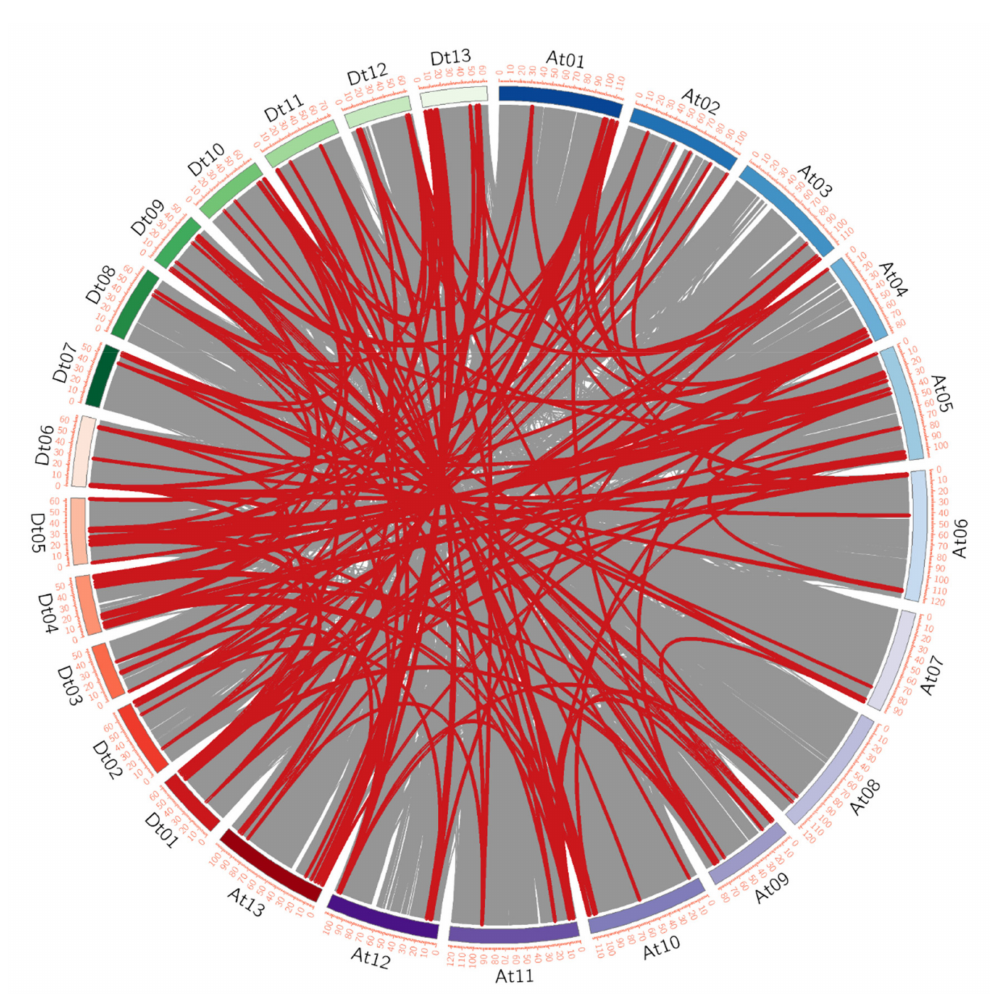
Figure 3. The syntenic relationship of GhAAT . The synteny of GhAATs in G. hirsutum L. marked with red lines. The grey lines indicated all the synteny relationships in G. hirsutum L. genome.